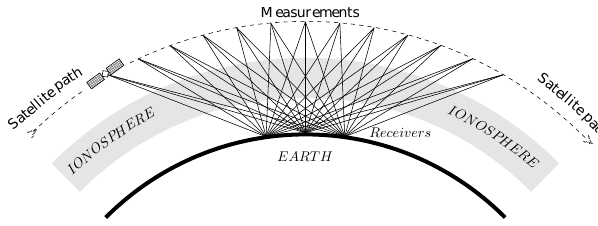
Figure 2. Schematic plot of ionospheric tomography with LEO bea- con satellites.